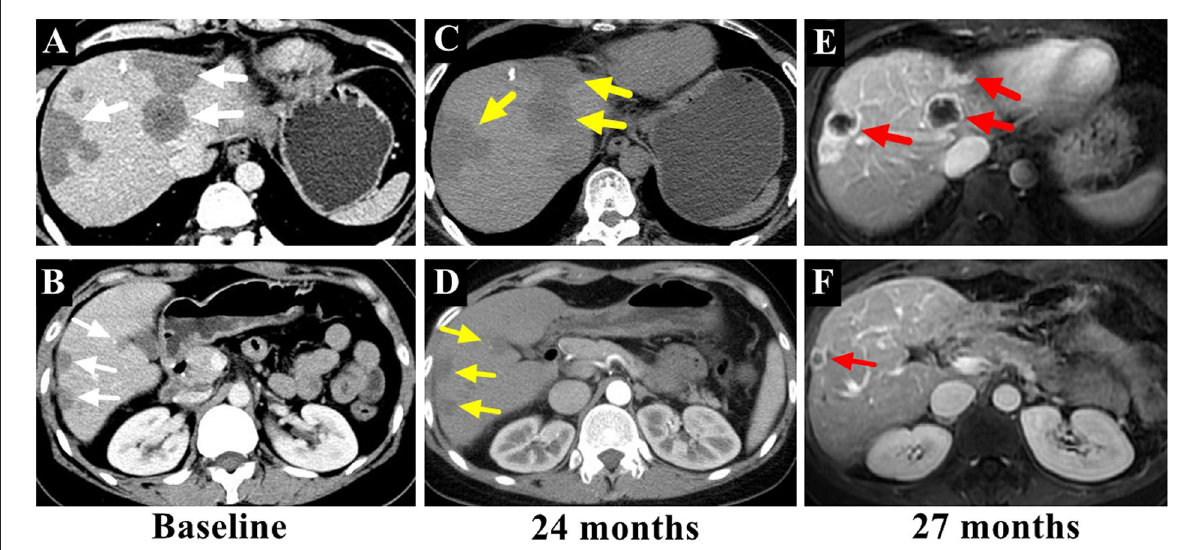
FIGURE4 The intrahepatic lesions [ (A,B) , marked with white arrows] were stable after 2 years of treatment with anlotinib monotherapy [ (C,D) , marked with yellow arrows], while the lesions regressed or disappeared after 3 months of combined therapy with anlotinib and IFN-a 2b [ (E,F) , marked with red